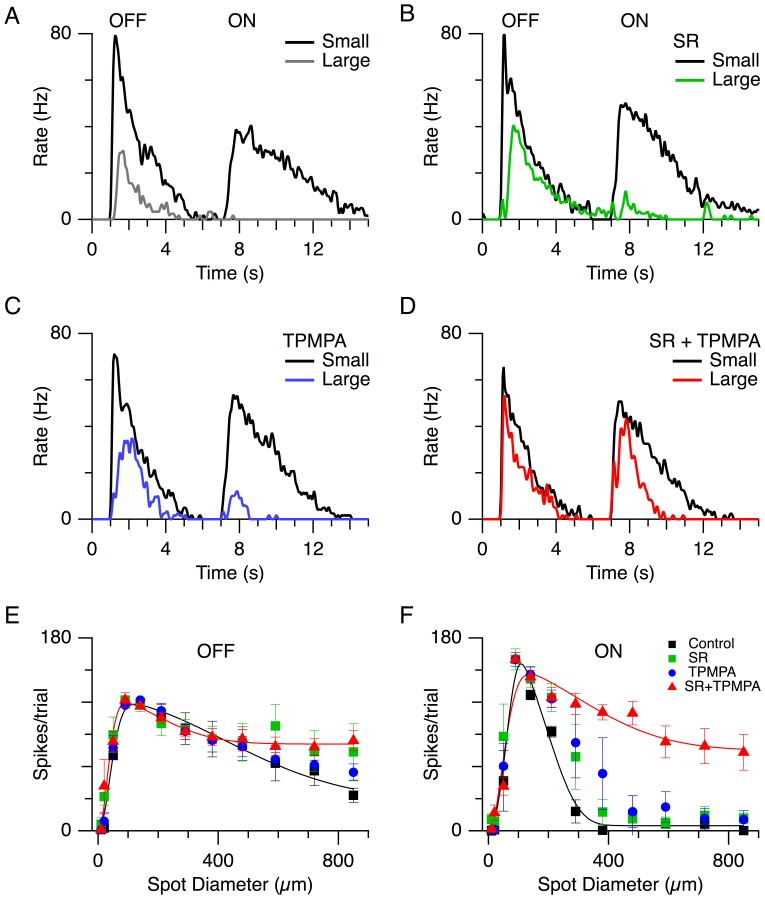
GABAergic inhibition contributes to surround suppression in LEDs.Spike-time histograms averaged from 4 cells, showing responses to a small dark spot (100 µm diameter, dark trace) or large dark spot (850 µm diameter, lighter trace). (A) Control shows that the large spot produced strong surround suppression. Surround suppression is partially relieved in both OFF and ON systems during selective application of 10 µM SR, a GABAA antagonist (B) and 30 µM TPMPA, a GABAC antagonist (C). (D) Surround suppression was relieved when GABAergic transmission was blocked by co-application of SR-95331and 30 µM TPMPA. (E,F) The total number of spikes per trial as a function of the stimulus spot size, for the same 4 cells; the data points (mean ± SD) have been normalized to the average value obtained for the 100 µm spot in control. Control, black; SR, green; TPMPA, blue; SR+TPMA, red.